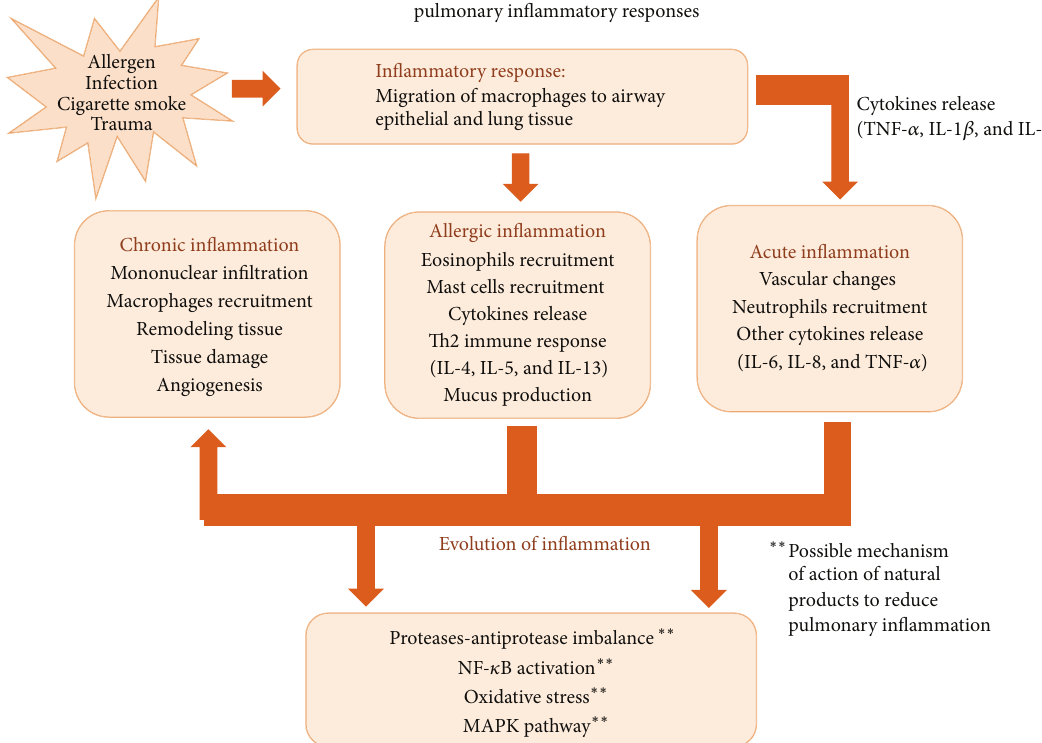
Figure 2: Possible mechanism involved in the effects of herbal-derived natural products on pulmonary inflammation in respiratory diseases. It is believed that the natural products derived from plants inhibit the pulmonary inflammation by the inhibition of the transcription of NF- 𝜅 B to the nucleus, thus preventing the development of all the inflammatory processes triggered by allergen, cigarette smoke, virus, or bacteria. Therefore, these products can reduce the inflammatory cytokines release and oxidative stress. These effects together culminate with the improvement of lung function and with the reduction of pulmonary